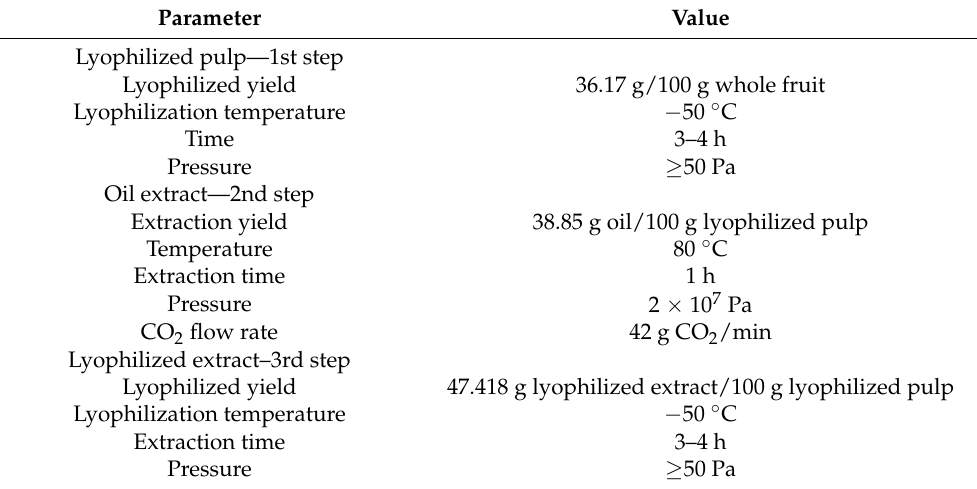
Table 2. Experimental data used to simulate the sequential two-stage process using supercritical and conventional solvent extraction